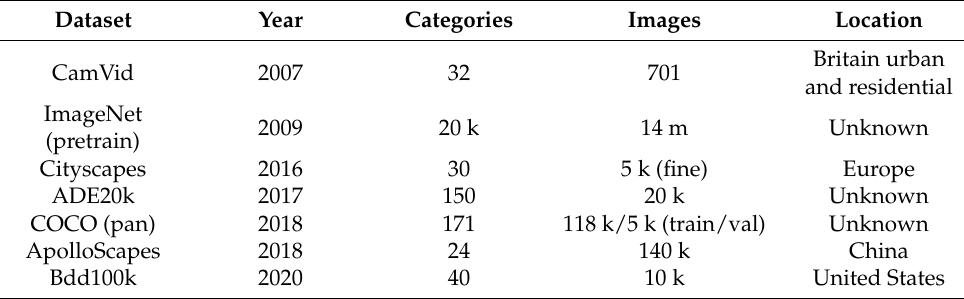
Table 1. Information of different datasets related to semantic segmentation.